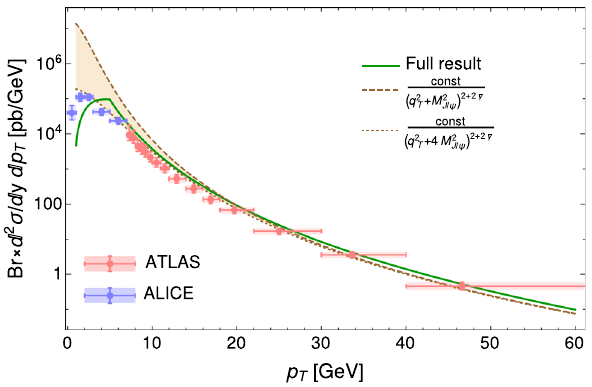
Fig. 4 Solid green line corresponds to the shape of the q T distribu- tion of produced J /ψ at central rapidities described in the text. The threshold scale q 0 is chosen as q 0 ∼ 5 GeV. Dashed and dotted brown lines correspond to an asymptotic form ∼ 1 / in the text, with parameter (cid:13) c ≈ ( 1 − 2 ) M J /ψ The experimental data are taken from Refs.